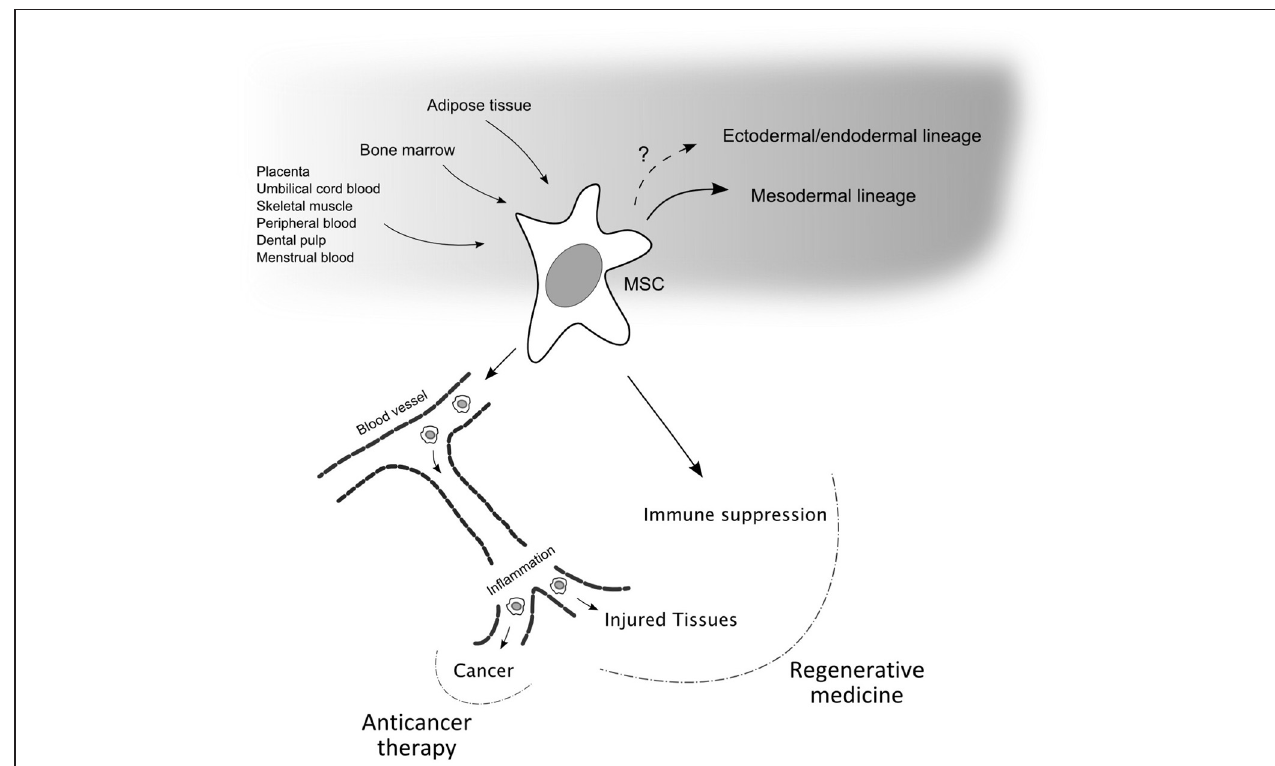
FIGURE 1 | Mesenchymal stem cell properties and relevance for therapeutic applications. Mesenchymal stem cells (MSCs) can be isolated from different sources, in particular from bone marrow and adipose tissues, and can differentiate into various cell types of the mesodermal germ layer. The possibility that these adult stem cells can differentiate in cells of the other germ layers is not excluded and is still debated. Two main properties make MSCs good candidates for therapeutic applications. First, their ability to enter